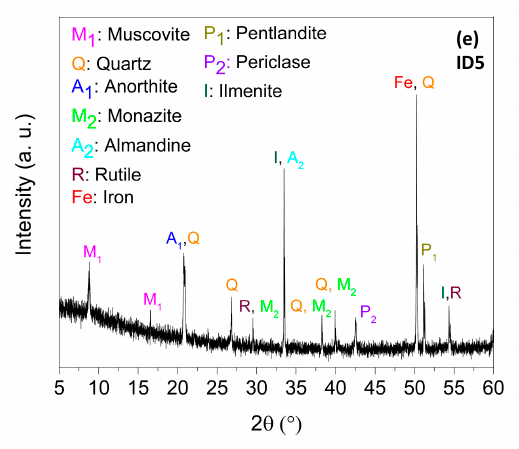
Figure 3. X-ray diffraction spectra of samples ID# (# = 1, …, 5) ( a – e ).